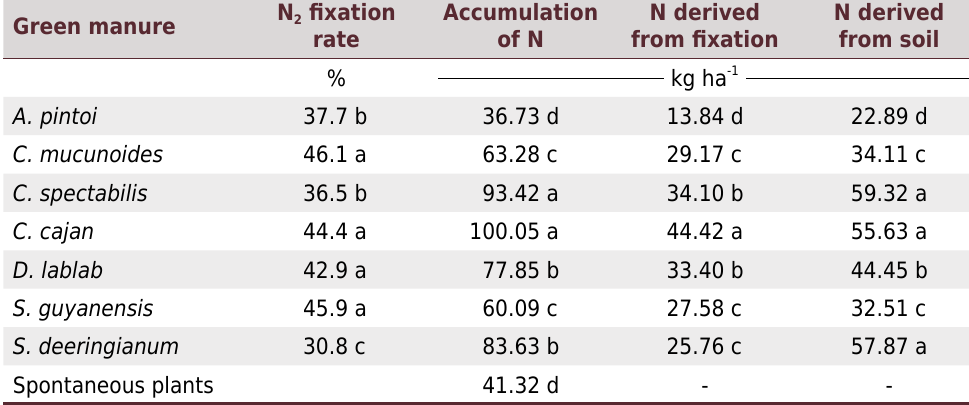
Table 3. N 2 fixation rate, total accumulation of nitrogen, nitrogen derived from biological fixation, and nitrogen derived from the soil in the green manure crop intercropped with coffee in the Zona da Mata region, state of Minas Gerais, Brazil Green manure